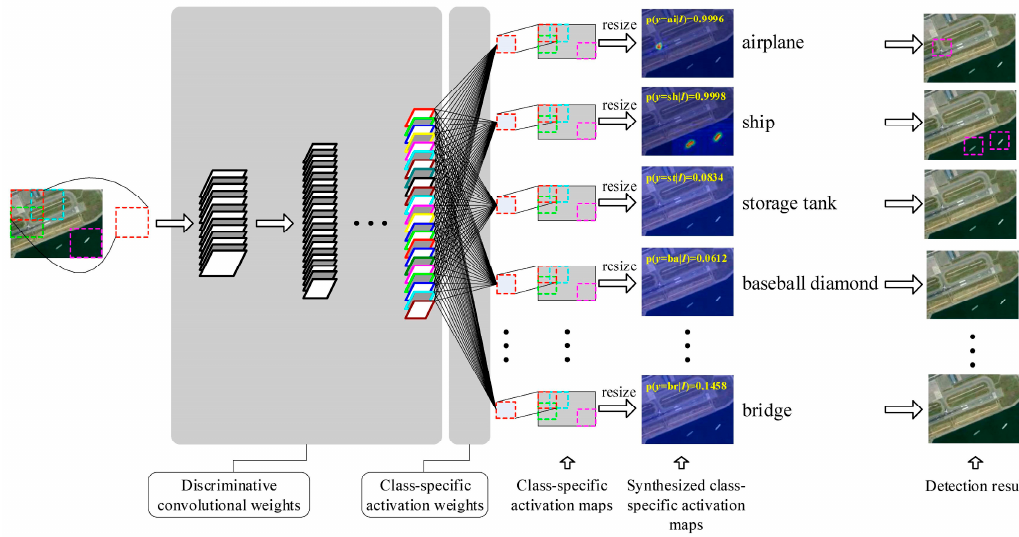
Figure 7. Scene-level supervised object detection based on deep networks.